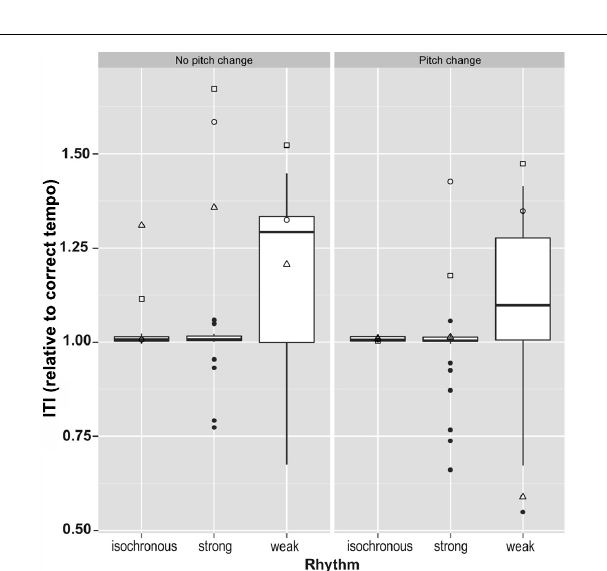
FIGURE 4 | Mean tapping rates relative to correct tapping rate in all six conditions for the three dysrhythmics compared to the controls. Here, control data largely lies within very small limits for the isochronous and strongly metrical conditions. (cid:3) = SS; ◦ = SWI; (cid:4) = VPO.